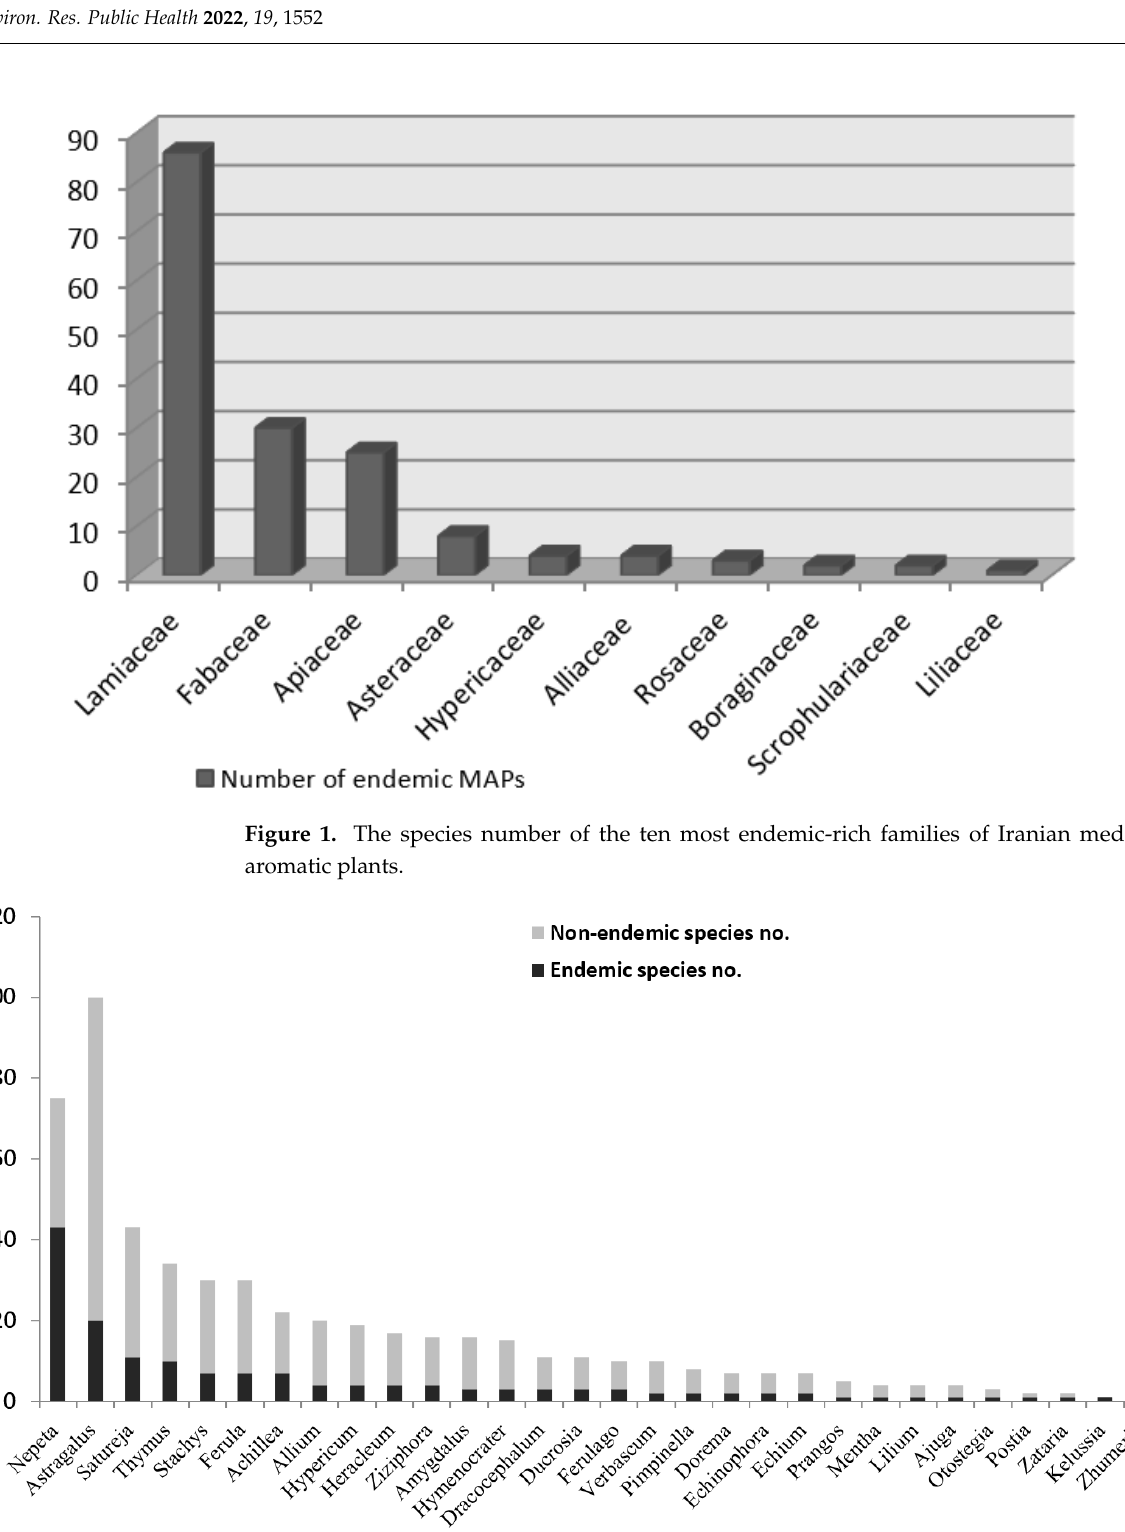
Figure 2. The frequency of endemic and non-endemic species of the 30 most endemic-rich genera of the Iranian medicinal and aromatic plants.